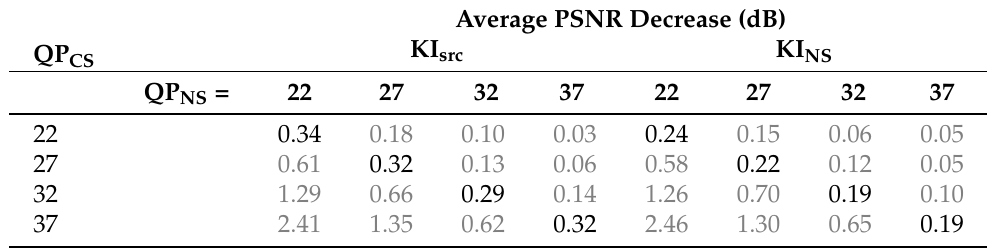
Table 4. Average decrease in Peak Signal-to-Noise Ratio (PSNR).